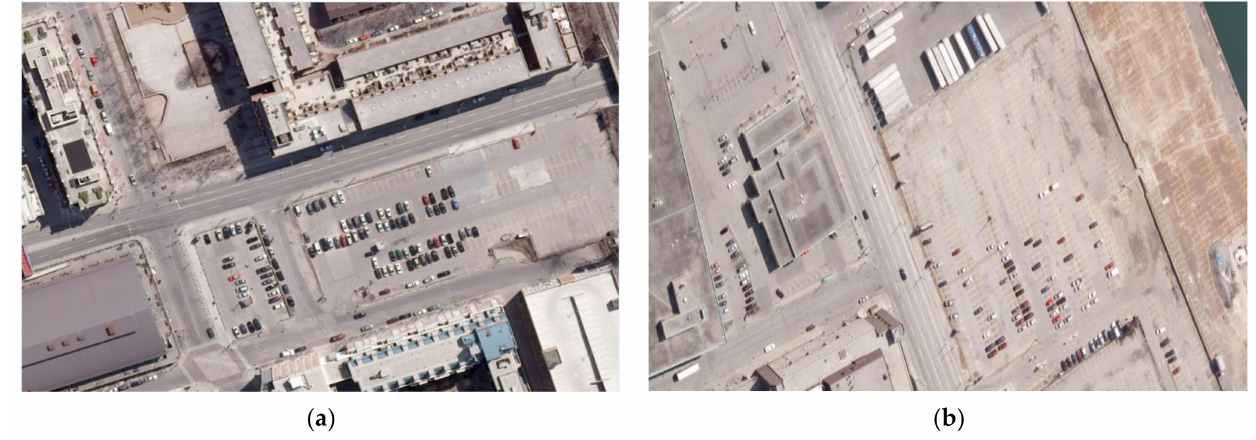
Figure 3. Two images of Toronto dataset: ( a ) image A. ( b ) image